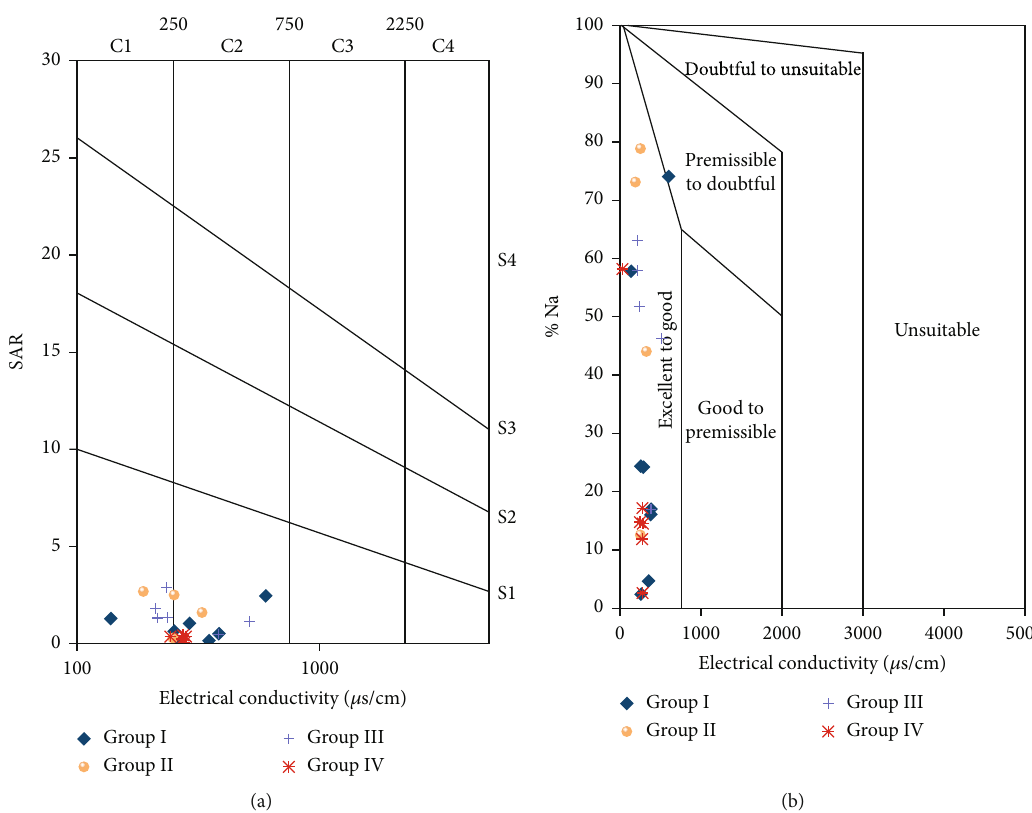
Figure 12: USSL and Wilcox plots for tunnel irrigation water classi fi